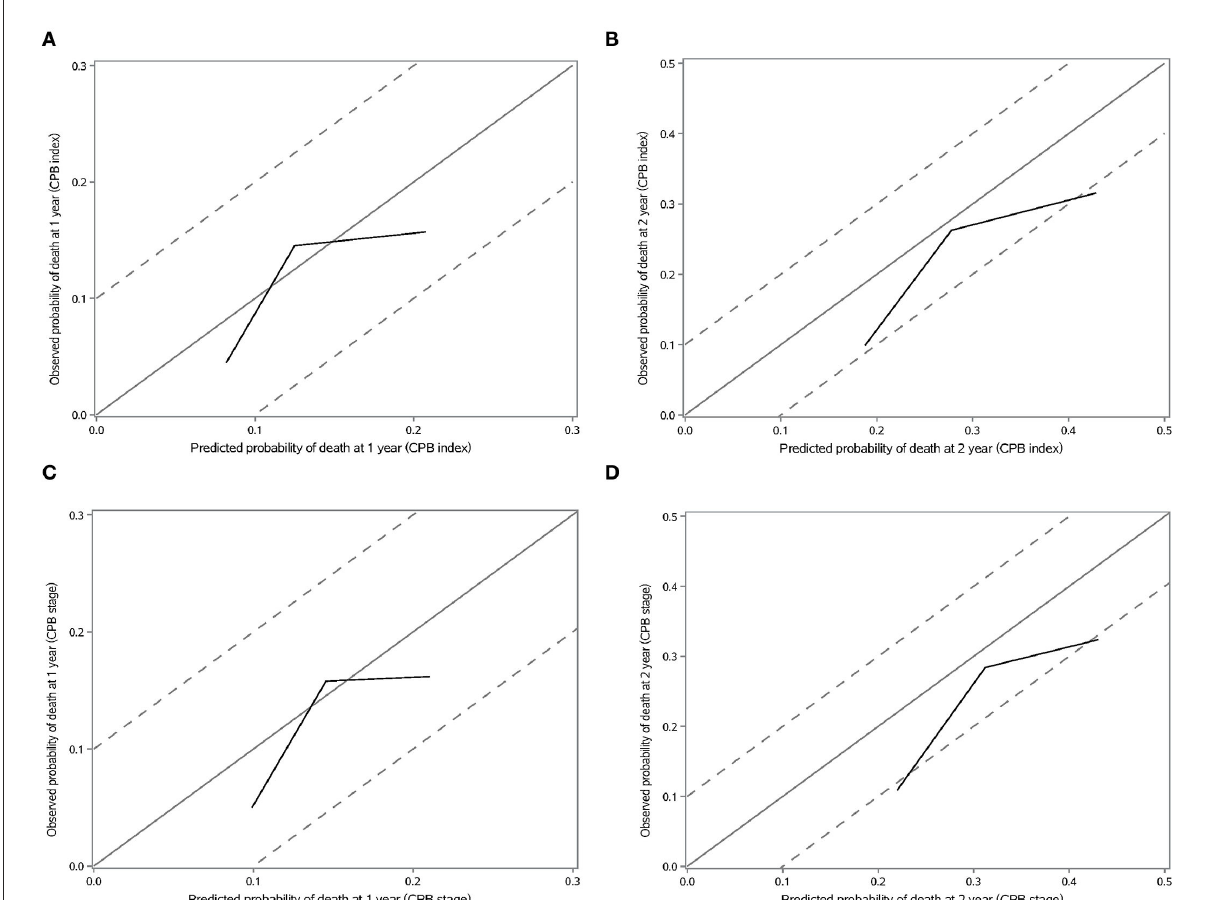
FIGURE4 Calibration plot of CPB index and CPB stage for 1-year and 2-year mortality. (A) Calibration plot of CPB index for 1-year mortality. (B) Calibration plot of CPB index for 2-year mortality. (C) Calibration plot of CPB stage for 1-year mortality. (D) Calibration plot of CPB stage for 2-year